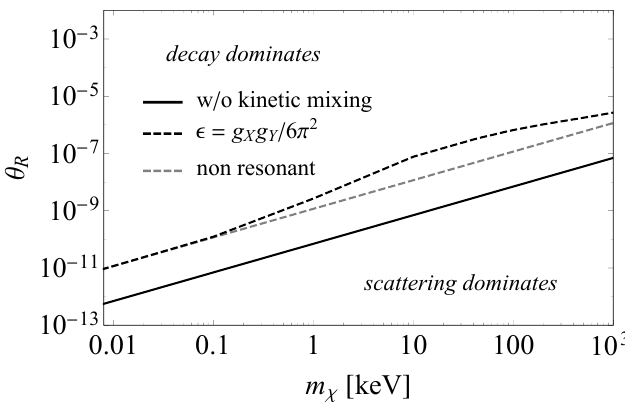
Figure 2 . Regions where VDM production is dominated by decay ( R ≡ Y 2 → 2 2 → 2 scattering processes ( R > 1 ) in the m χ − θ R plane, for cases without kinetic mixing (solid) and with (cid:15) = g X g Y / (6 π 2 ) (dashed), and assuming m E = 1 TeV. The gray curve shows the scattering- to-decay ratio without the resonant enhancement from mixing with the photon in the